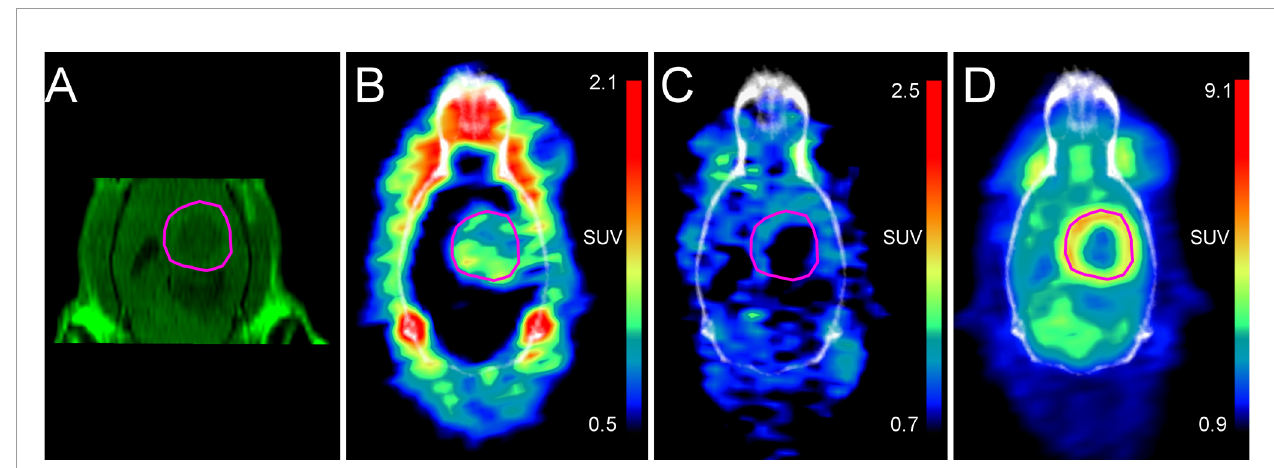
FIGURE 2 | Comparative in vivo coronal-image array of a single BDIX rat subject's head region with MRI-based boundaries of a BT4C glioma (outlined in magenta) imaged on four consecutive days (PET/CT images depicted are from the Inveon PET/CT camera system). (A) MRI, (B) PET/CT, 15.8 MBq injection of [ 18 F]FGln,